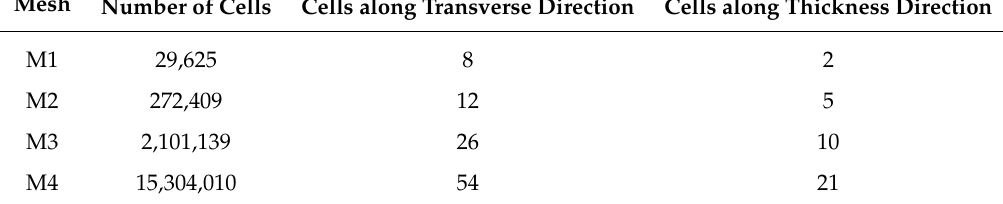
Table 11. Moldex3D R (cid:13) [11] meshes employed in Case Study 3.